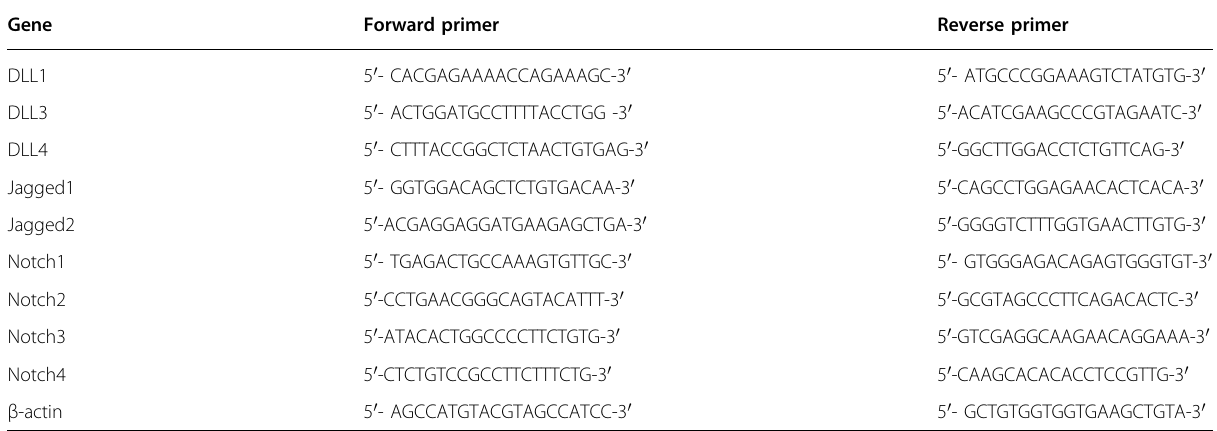
Table 1 Primer sequences used in qRT-PCR